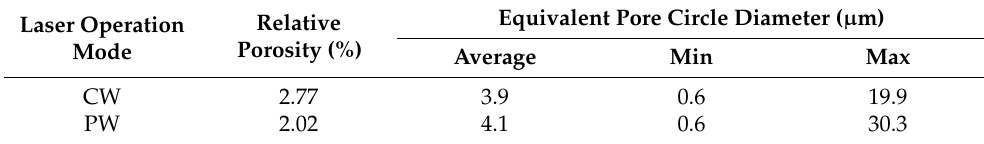
Table 7. Porosity at starting position within the remelting zone of the laser polished tensile specimens. Laser Operation